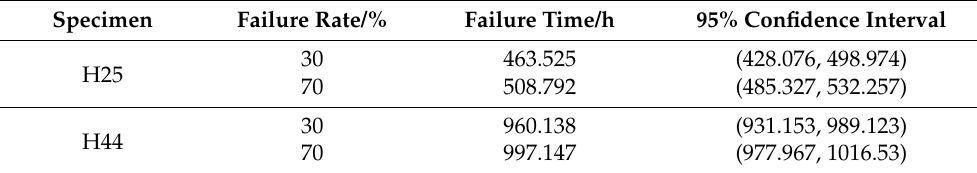
Table 9. The failure time corresponding to the accelerated life failure rate of MOCRC.